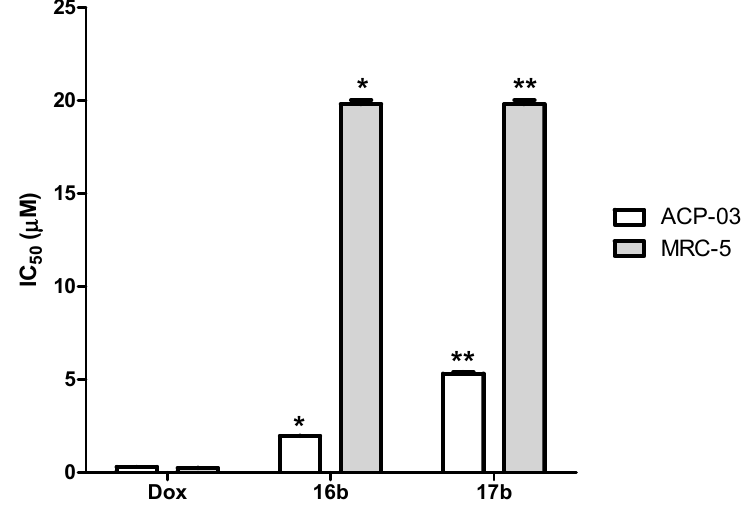
Figure 2. Comparison of the IC values of derivatives against a gastric cancer cell line 50 (ACP-03) and normal fibroblast cell line